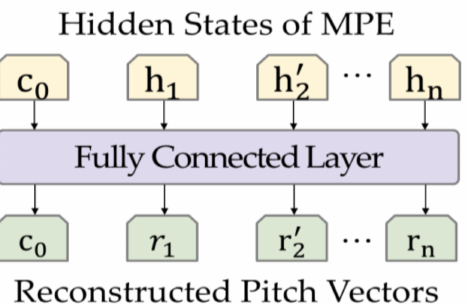
Figure 3. Reconstruction decoding processing follow by MPE. c denotes the classification token. r (cid:48) n denotes the reconstruction vector predicted by the model.